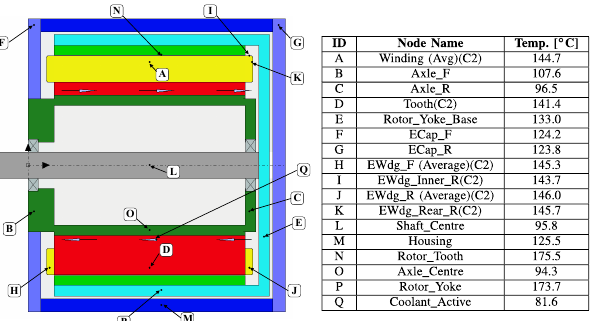
Figure 14. Steady-state temperatures in the axial cross-section of SRM at 3400 RPM and 730 Nm.